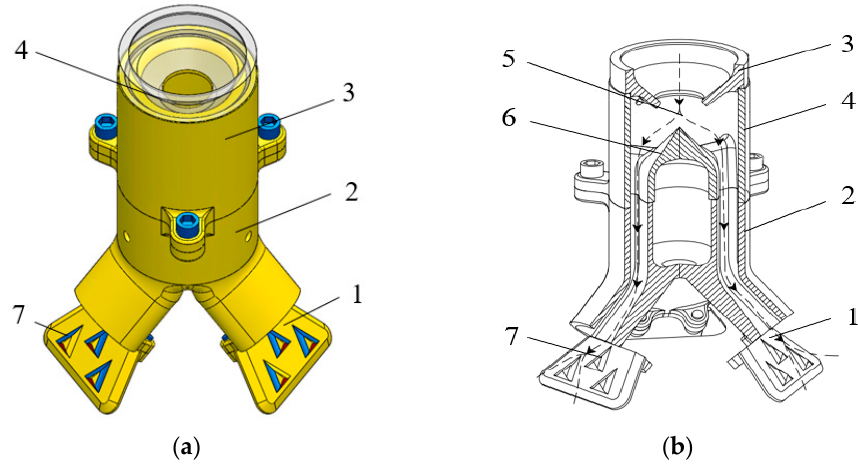
Figure 1. A structural diagram of the corn-overlapped strip fertilizer spreader; ( a ) structural model diagram; ( b ) cross-sectional view: 1. fattening small plates, 2. lower fertilizer spreading tube, 3. upper fertilizer spreading tube, 4. fertilizer funnel, 5. fertilizer falling path, 6. fertilizer cone, 7. fattening bulges.